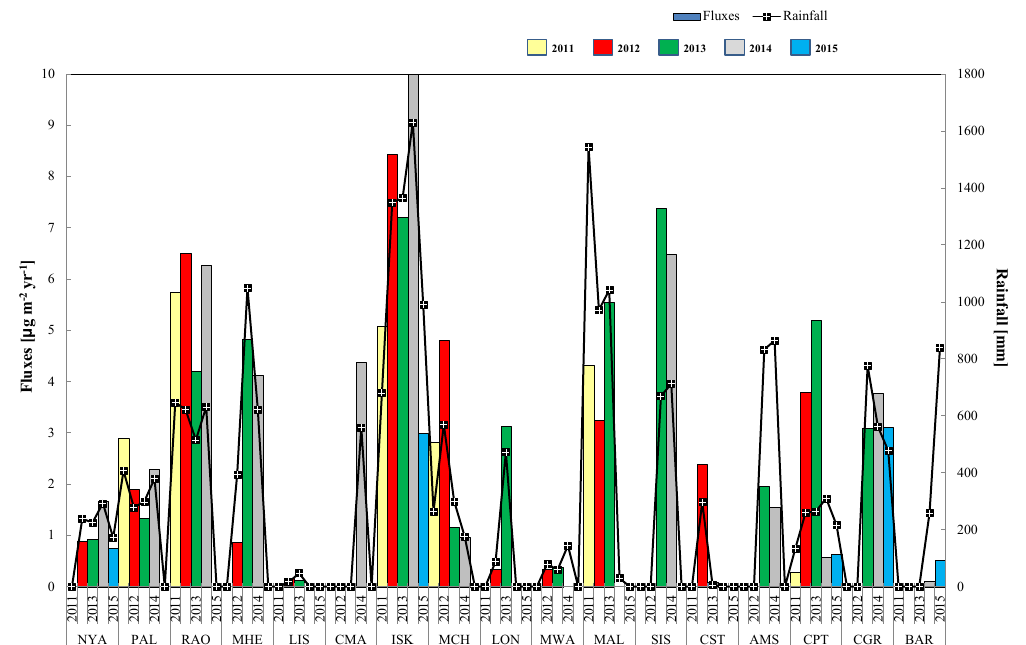
Figure 2. Annual wet deposition fluxes and the corresponding cumulative precipitation amounts (rainfall), observed at the 17 GMOS sites during